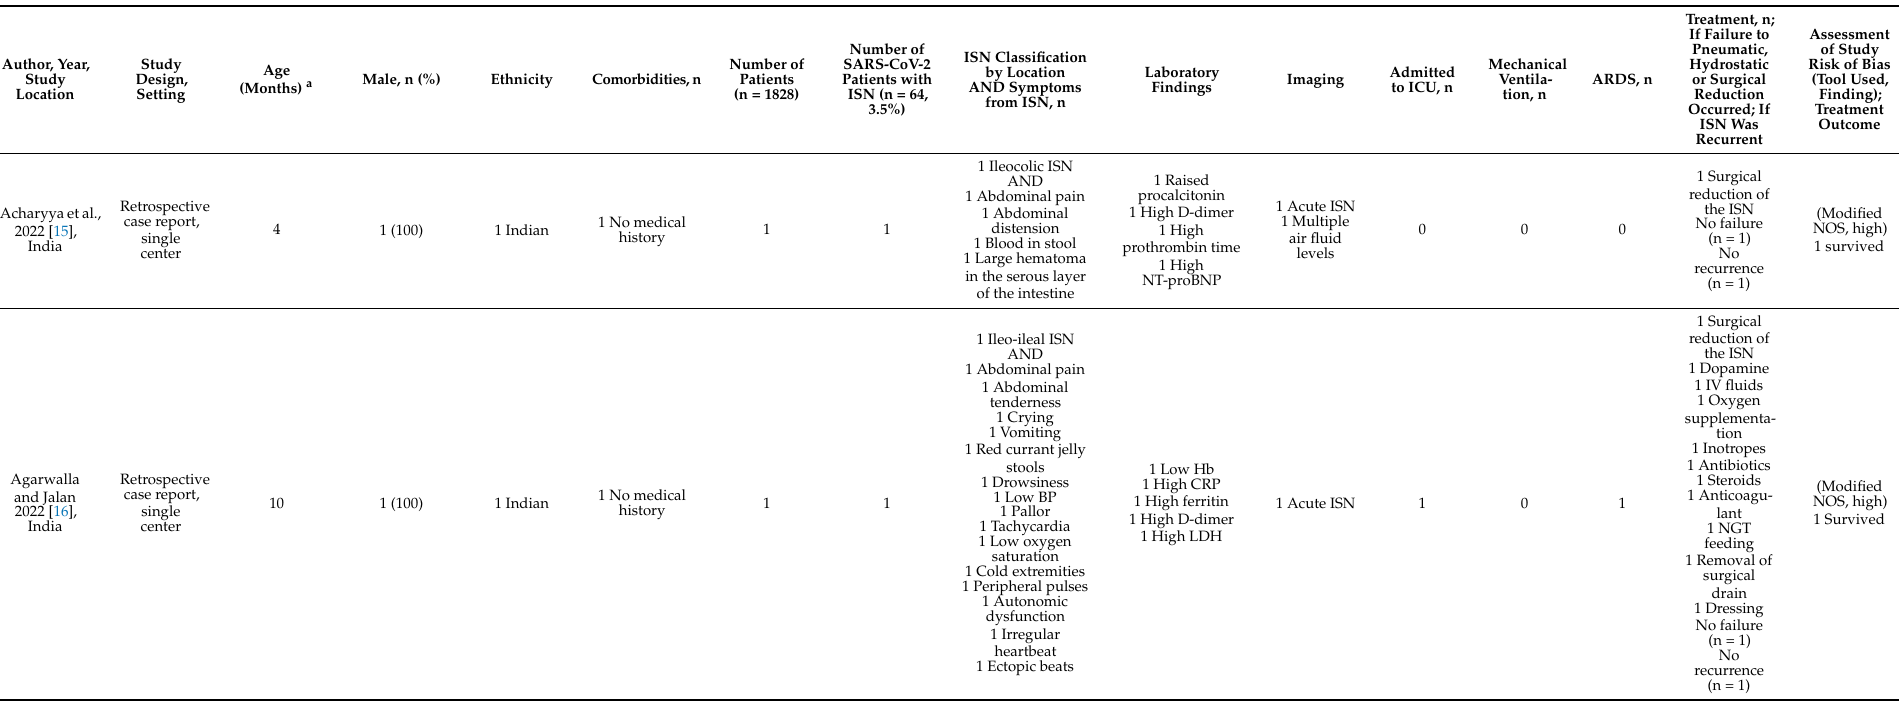
Table 1. Summary of the characteristics of the included studies with evidence on ISN and COVID-19 in pediatric patients (n = 34 studies),